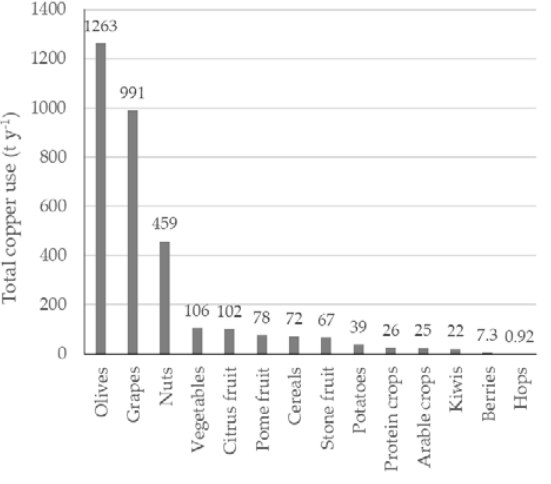
Figure 4. Total estimated copper consumption (t y − 1 ) in organic farming in the 12 surveyed European countries. Crops were aggregated into crop categories (for details, see Supplementary